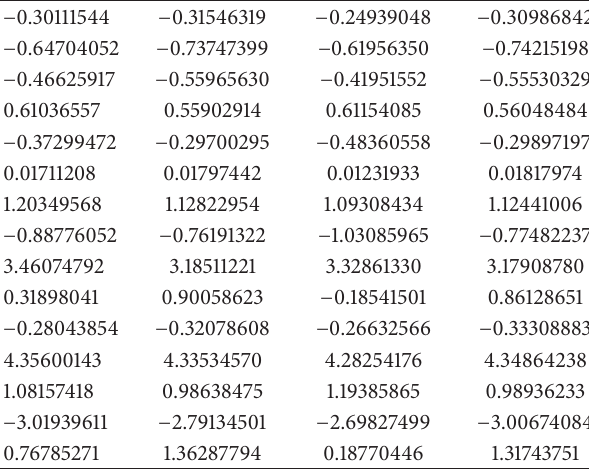
Table 7: Weight matrix of output layer (𝑊 𝑜 ) 15×4 . Table 8: Bias vector of hidden layer ( 𝜃 ℎ ).